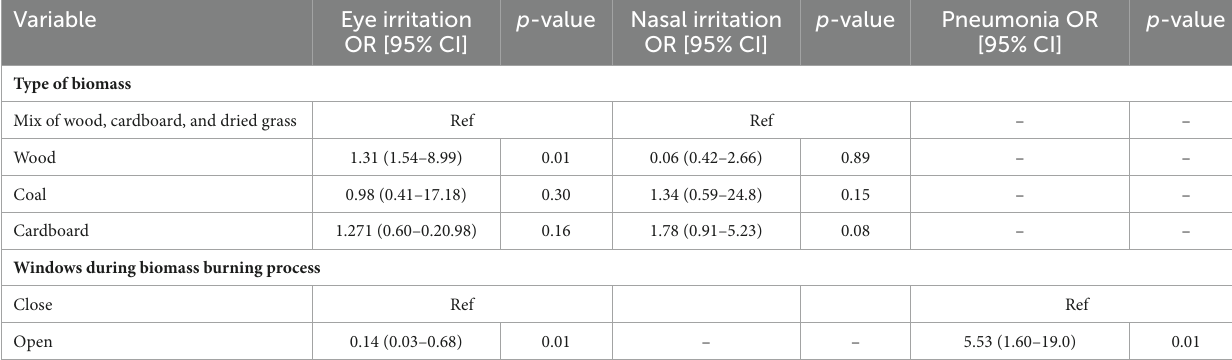
TABLE 7 Logistic regression analysis results for experienced symptoms/morbidities and independent